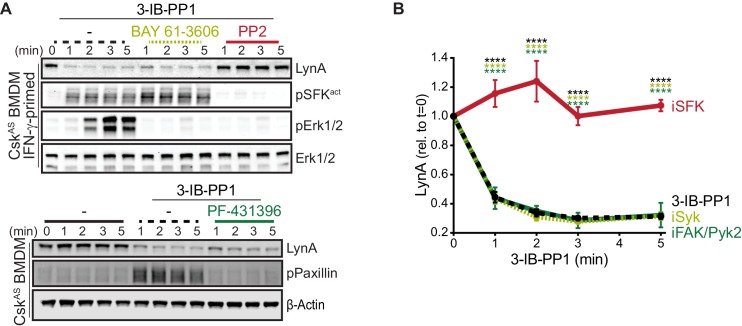
Syk, FAK, and Pyk2 kinase activities are not necessary for the rapid degradation of LynA.(A) Immunoblots showing expression of endogenous LynA protein in CskAS BMDMs treated with 3-IB-PP1 only or cotreated with 3-IB-PP1 and the Syk inhibitor BAY 61–3606, the SFK inhibitor PP2, or the FAK/Pyk2 inhibitor PF-431396. Activated signaling proteins including SFKs (pSFKact, activation-loop-phosphorylation corresponding to SrcpY416), pErk1/2, and PaxillinpY118 (pPaxillin) are shown as controls for inhibitor function; β-Actin and total Erk1/2 are shown as loading controls. (B) Quantification of LynA protein during 3-IB-PP1 treatment only (black dotted) or with the inhibitors BAY 61–3606 (iSyk, light olive), PP2 (iSFK, red), or PF-431396 (iFAK/Pyk2, green), corrected for total protein content (TPS) and reported relative to the steady-state level of LynA. SEM, n = 3. Sig. from ANOVA2-Tukey: [3-IB-PP1 only vs. 3-IB-PP1+PP2, black asterisks], [3-IB-PP1+BAY 61–3606 vs. 3-IB-PP1+PP2, light olive asterisks], [3-IB-PP1+PF-431396 vs. 3-IB-PP1+PP2, green asterisks]; ****p<0.0001. Other pairs ns. Refer to Figure 5—source data 1.10.7554/eLife.46043.029Figure 5—source data 1.Quantification of LynA degradation in BMDMs treated with 3-IB-PP1 and inhibitors.